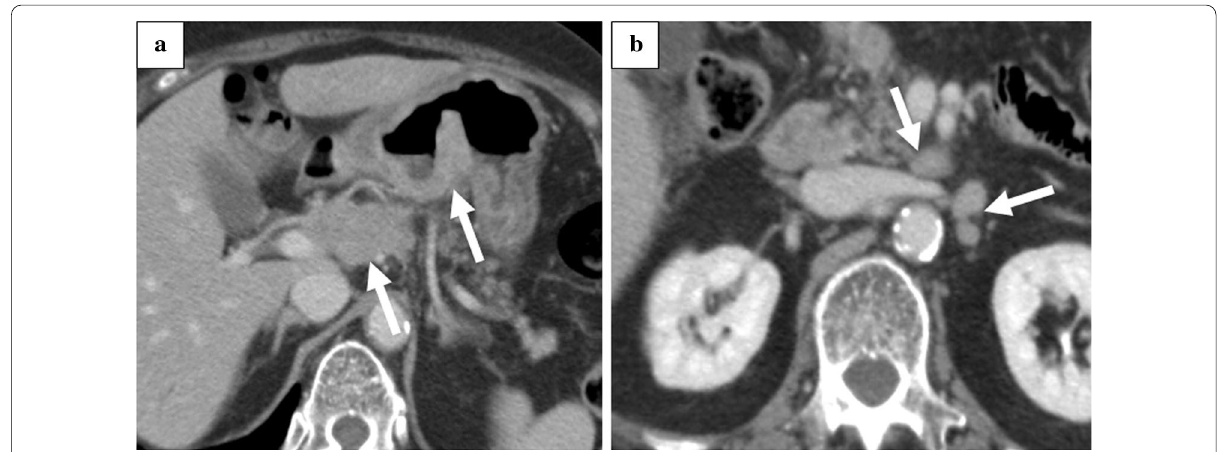
Fig. 2 Contrast-enhanced CT at the time of diagnosis. a Thicker gastric wall and enlarged regional lymph nodes (No. 8a). b High-density and enlarged No. 16a2 lymph nodes